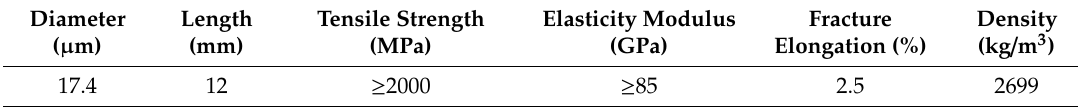
Table 2. Basalt fibers performance